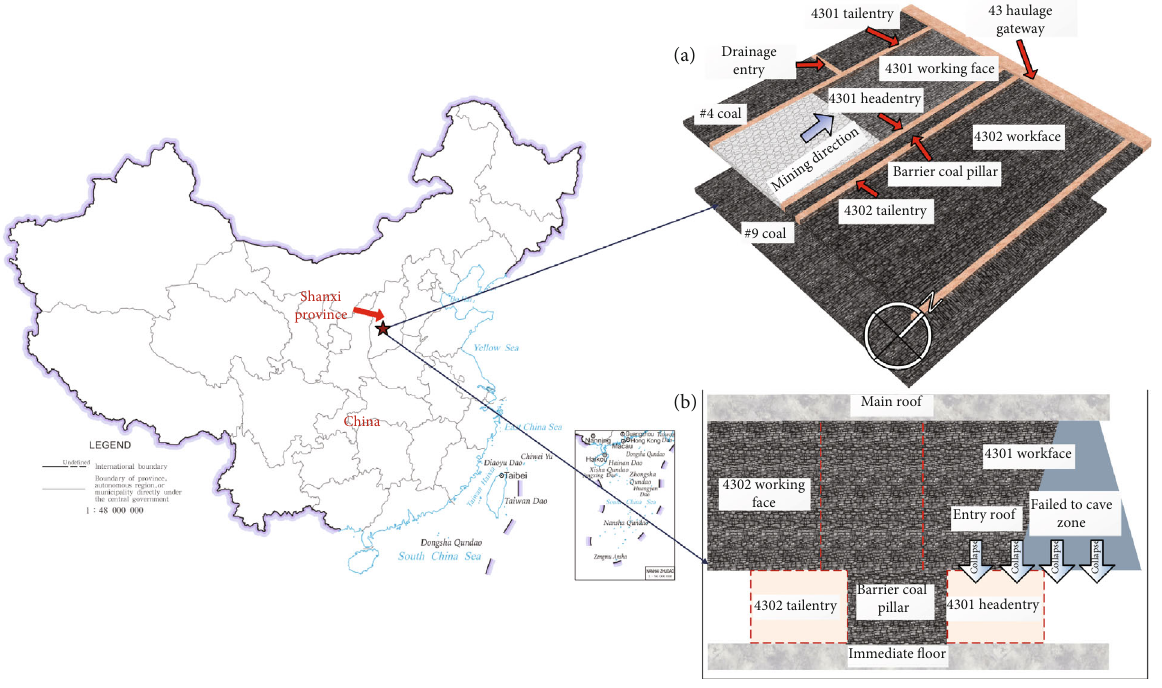
Figure 1: Mining conditions of Changheng